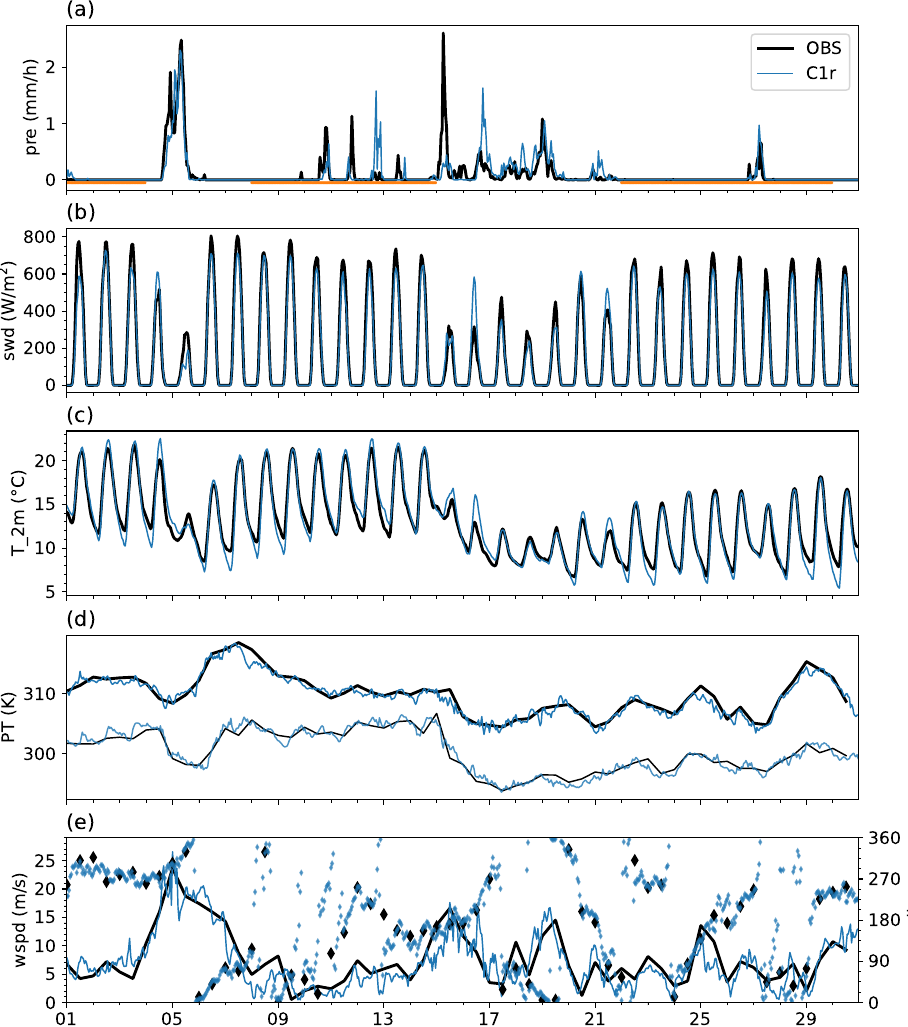
Figure 2. Overview of weather conditions during September 2016 from observations (black), and the reference simulation C1r (blue); based on an average over the valley-wind stations ( a – c ) and the twice-daily Payerne radiosonde data ( d , e ). Time series of ( a ) mean precipitation, ( b ) global radiation, ( c ) 2 m temperature, ( d ) potential temperature at 2000 m AGL (thin lines) and 4000 m AGL (thick lines), and ( e ) wind speed (lines) and wind direction (symbols) at 4000 m AGL. The orange lines in ( a ) denote the valley wind